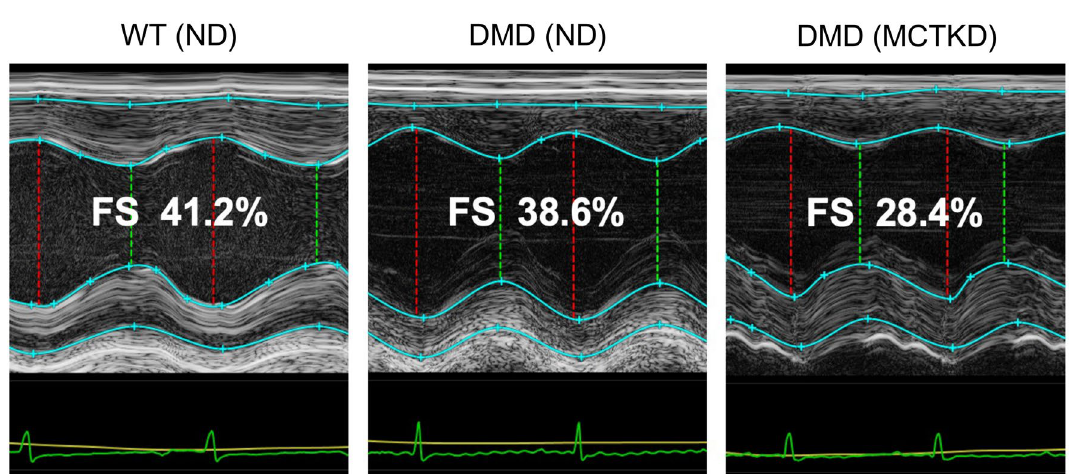
Figure 2. Representative images of echocardiography. A significant decrease in left ventricular (LV) fractional shortening (FS) was observed in MCTKD-fed DMD rats. Red and green lines indicate LV diameters at end- diastole and end-systole,